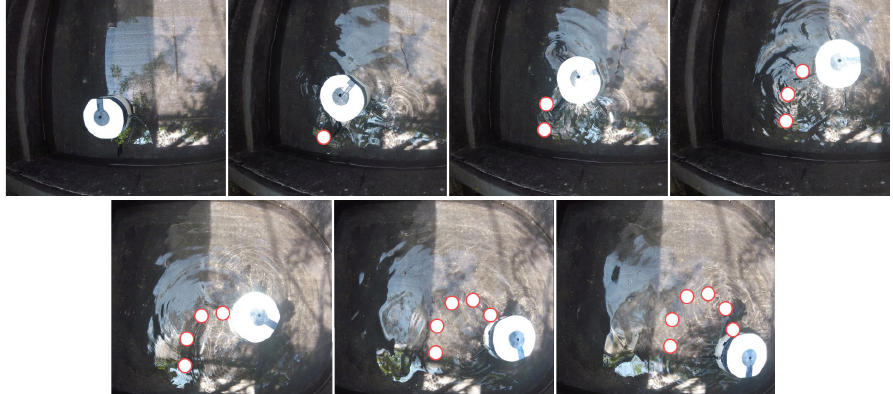
Figure 9. Video Sequences of C-Shape turning maneuver of the robotic fish.